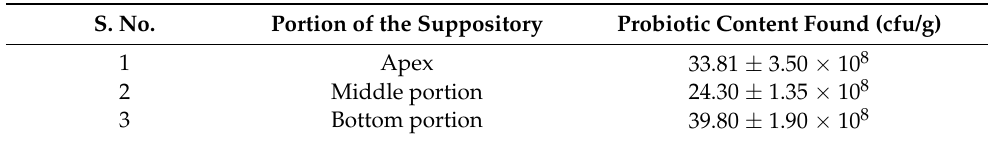
Table 1. Content uniformity within the